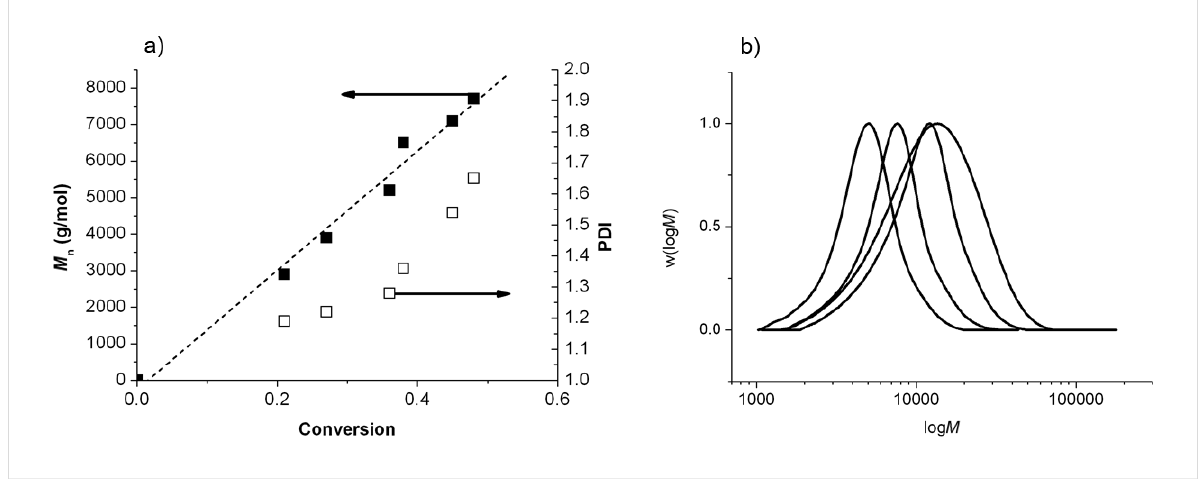
Figure 9: (a) Evolution of the number-average molar mass ( M n : filled symbol, linear fit: dash lines) and polydispersity index (PDI: empty symbols) with styrene conversion by using cello-SG1 as initiator. (b) Molar mass distribution (w(log M ) versus log M ) of the polystyrene chains at various conversions (DMA, 120 °C, [cello-SG1] 0 = 1.5 × 10 − 2 mol·L − 1 , [styrene] 0 = 1.4 mol·L − 1 ).